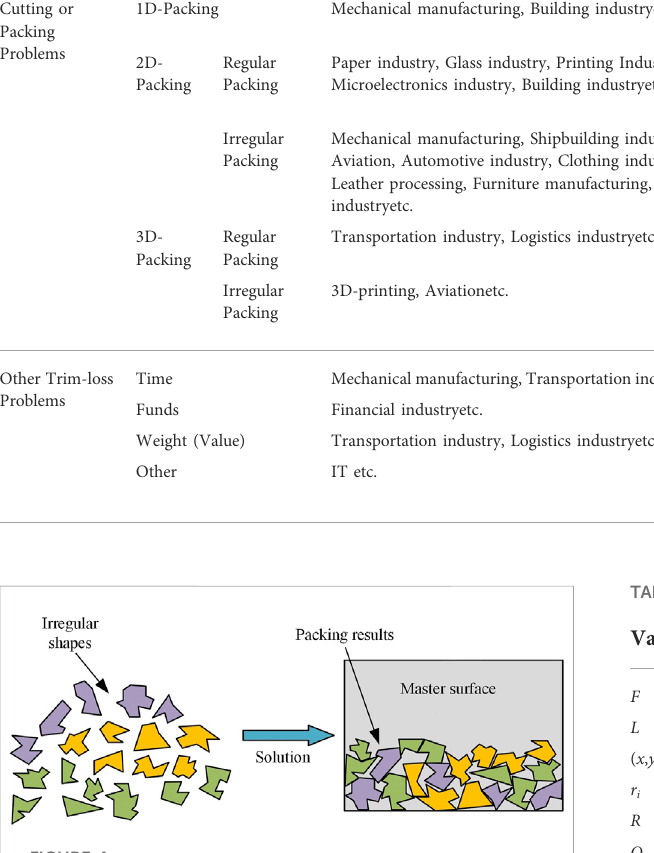
FIGURE 4 A simple 2D irregular packing problem.